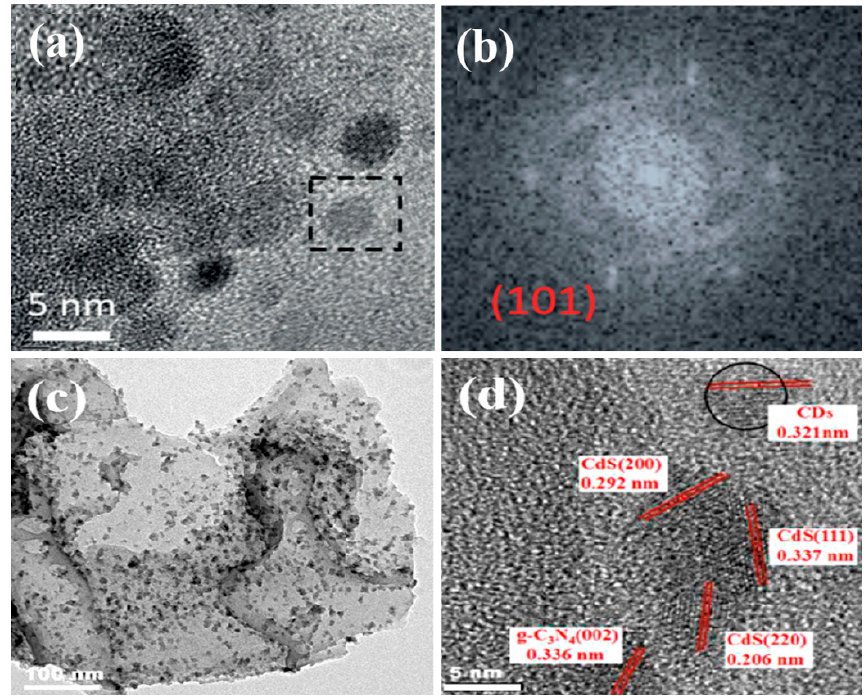
Figure 7. ( a ) HRTEM image of CCTs and ( b ) FFT pattern of the crystallite in ( a ) (reproduced with